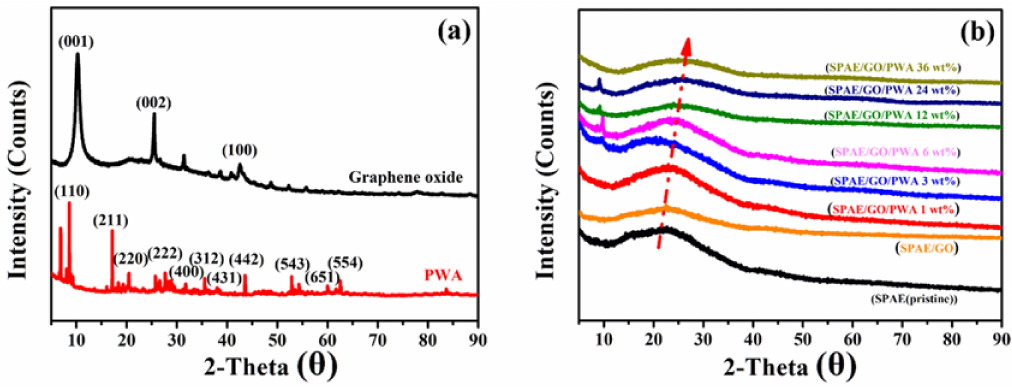
Figure 5. XRD patterns of ( a ) inorganic nanofillers, ( b ) SPAE composite